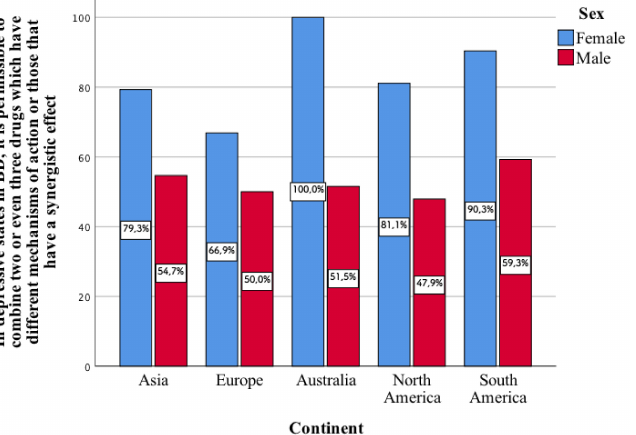
Figure 2. Opinion of the surveyed women and men on whether, in depressive states in bipolar disorder, it is permissible to combine two or even three drugs with different mechanisms of action or those that have a synergistic effect.